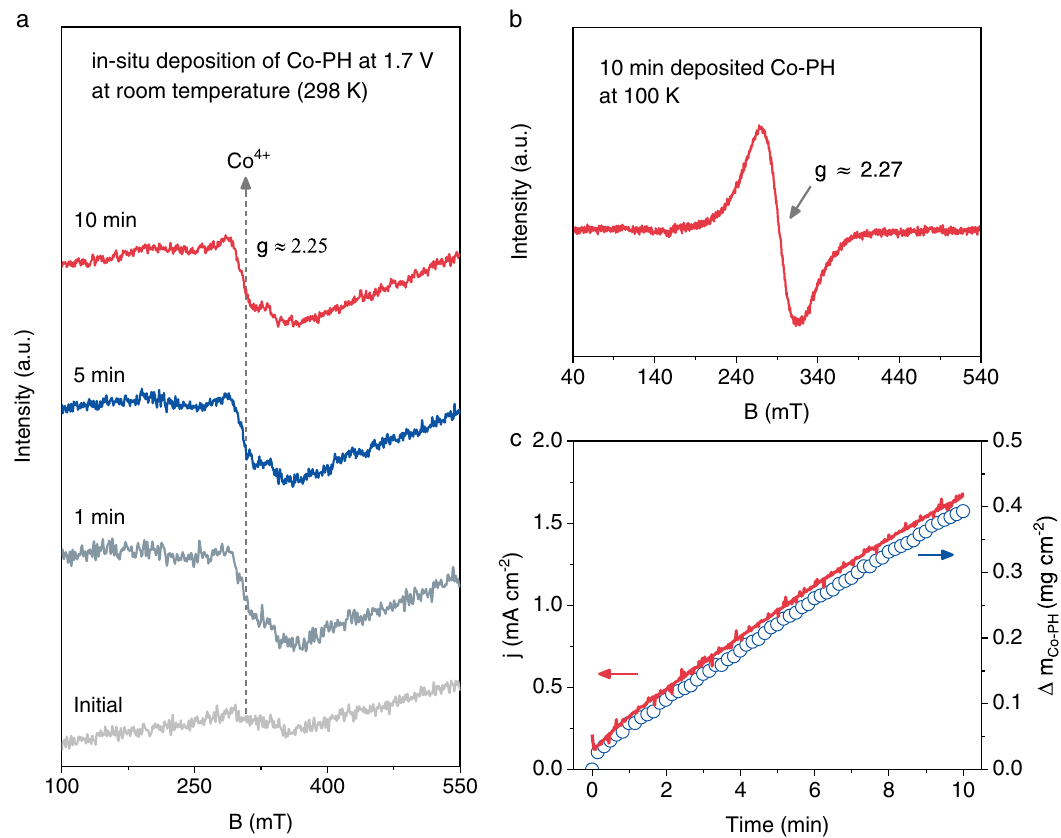
Fig. 5 | In situ electrodeposition of high-valence Co-PH fi lm containing non- bonding phen. a In situ EPR at 298K of the electrodeposited Co-PH catalyst at different time scales. b The ex situ EPR of the Co-PH catalyst at 100K after 10 min-